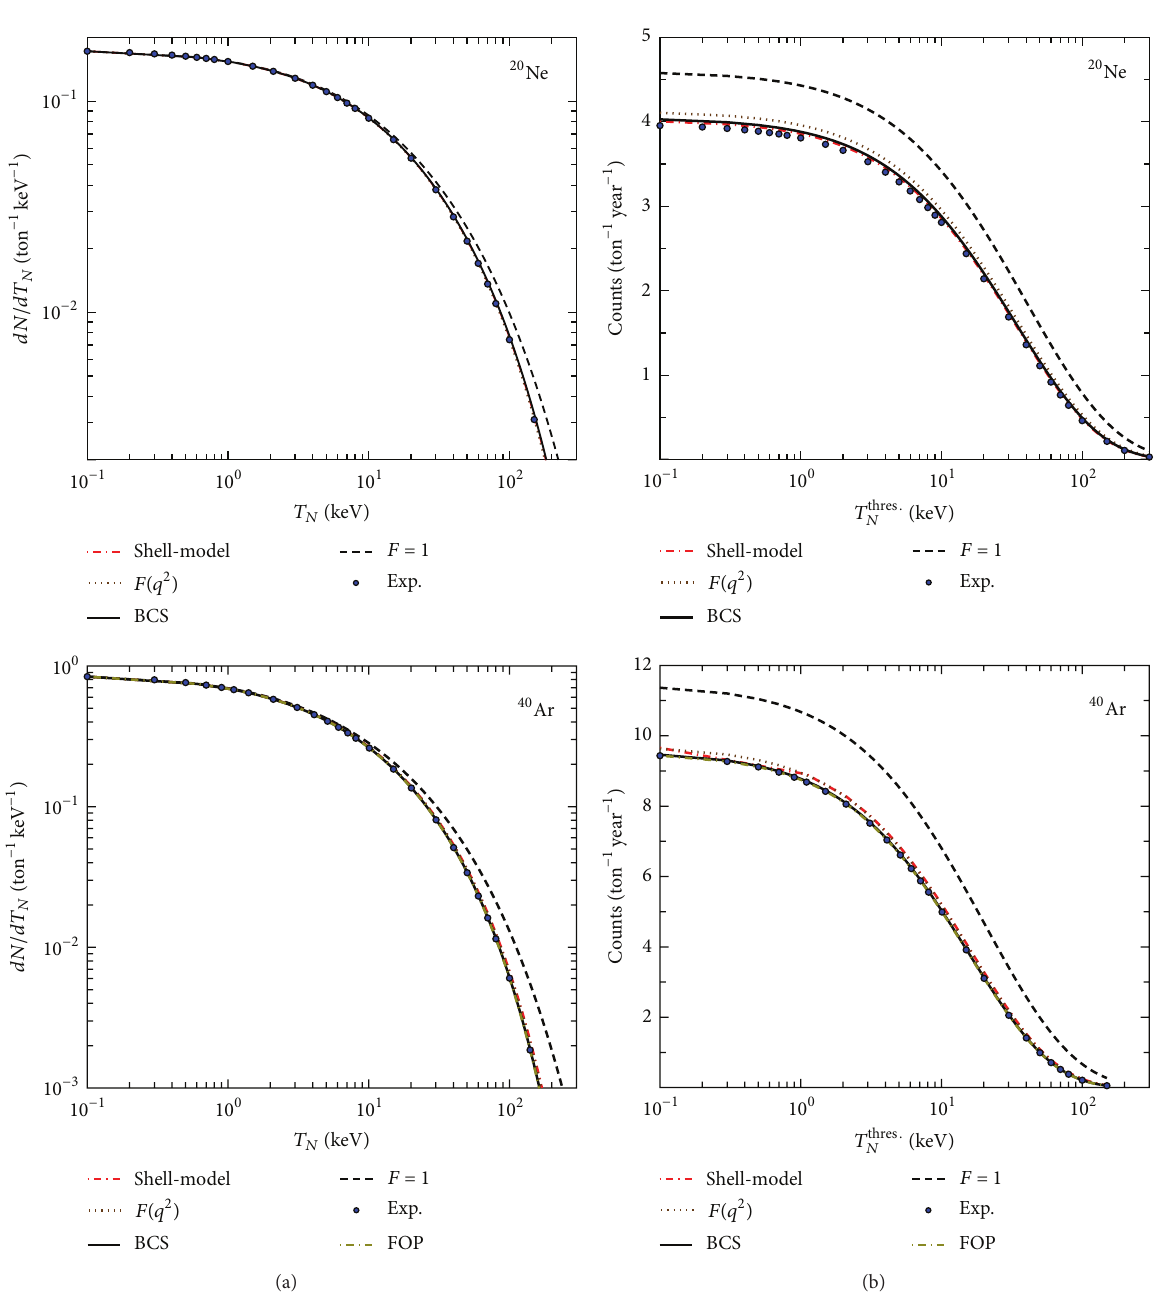
Figure 5: Yield in events (a) and total number of events over nuclear recoil threshold 𝑇 thres . 𝑁 (b), for supernova neutrinos at 𝑑 = 10 kpc. Here, 1 ton of perfectly efficient 20 Ne and 40 Ar detectors has been considered and also possible effects of neutrino oscillation in propagation are neglected. For heavier nuclear targets the differences become rather significant. In this figure, 𝐹(𝑞 2 ) stands for (21) and FOP for the method of fractional occupation probabilities of the states. For more details, see the